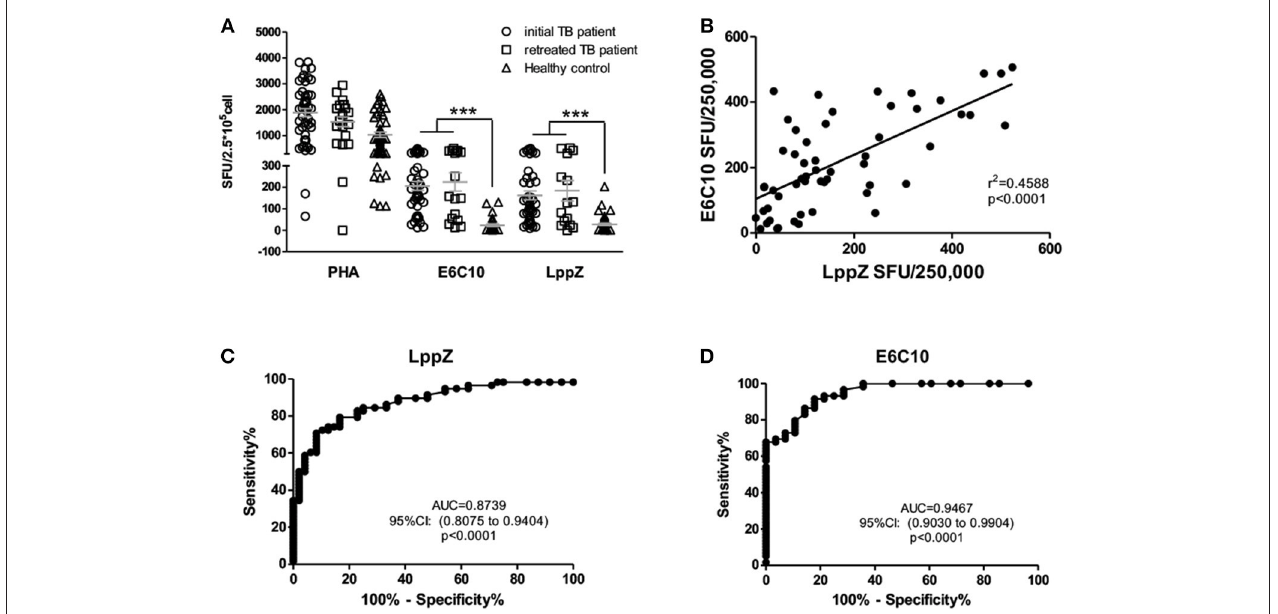
FIGURE 1 | LppZ induces high cellular responsiveness in TB patients . (A) The numbers of IFN- γ producing cells in TB patients (including initial TB patients and retreated TB patients) and HCs were assessed by ELISpot assay after stimulation with E6C10 fusion protein or purified LppZ protein. PHA served as a positive control. (B) Correlation analyses between LppZ- and E6C10-specific IFN- γ producing cells. (C,D) ROC curve analyses of LppZ- (C) and E6C10-specific (D) IFN- γ -producing cells in distinguishing TB patients and HCs. *** p < 0.0001. cells into the pouches when compared to the CMC-only